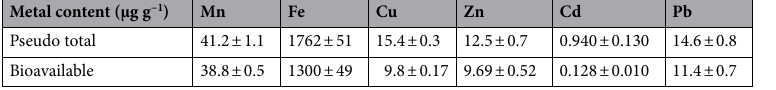
Table 1. Metals content in soil (mean ± SE, n = 5)